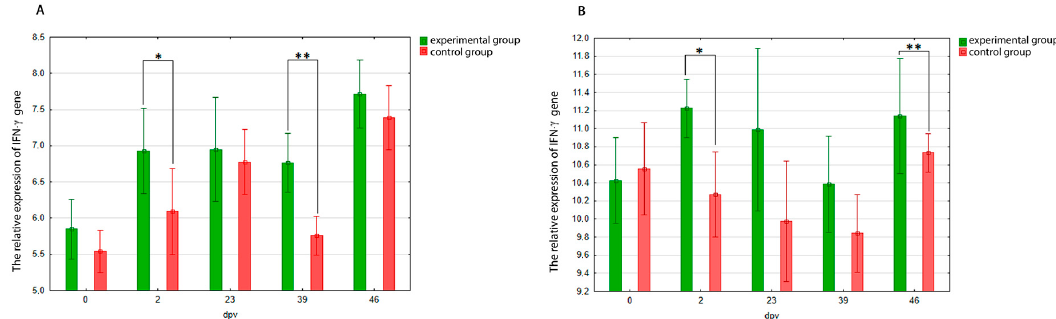
Figure 3. Mean relative expression of the genes encoding IFN- γ in blood ( A ) and splenic ( B ) mononuclear cells of pigeons immunized with PiCV rCP mixed with adjuvant (experimental group, E) or adjuvant only (control group, C) on day 0 and boosted on day 21. Samples were collected from pigeons of both studied groups on days 0, 2, 23, 39, and 46 after first immunization (dpv). The asterisks indicate a statistically significant difference between investigated groups, where * p < 0.05, ** p < 0.01 in U Mann-Whitney non-parametric test. Error bars represent the standard error of the mean.